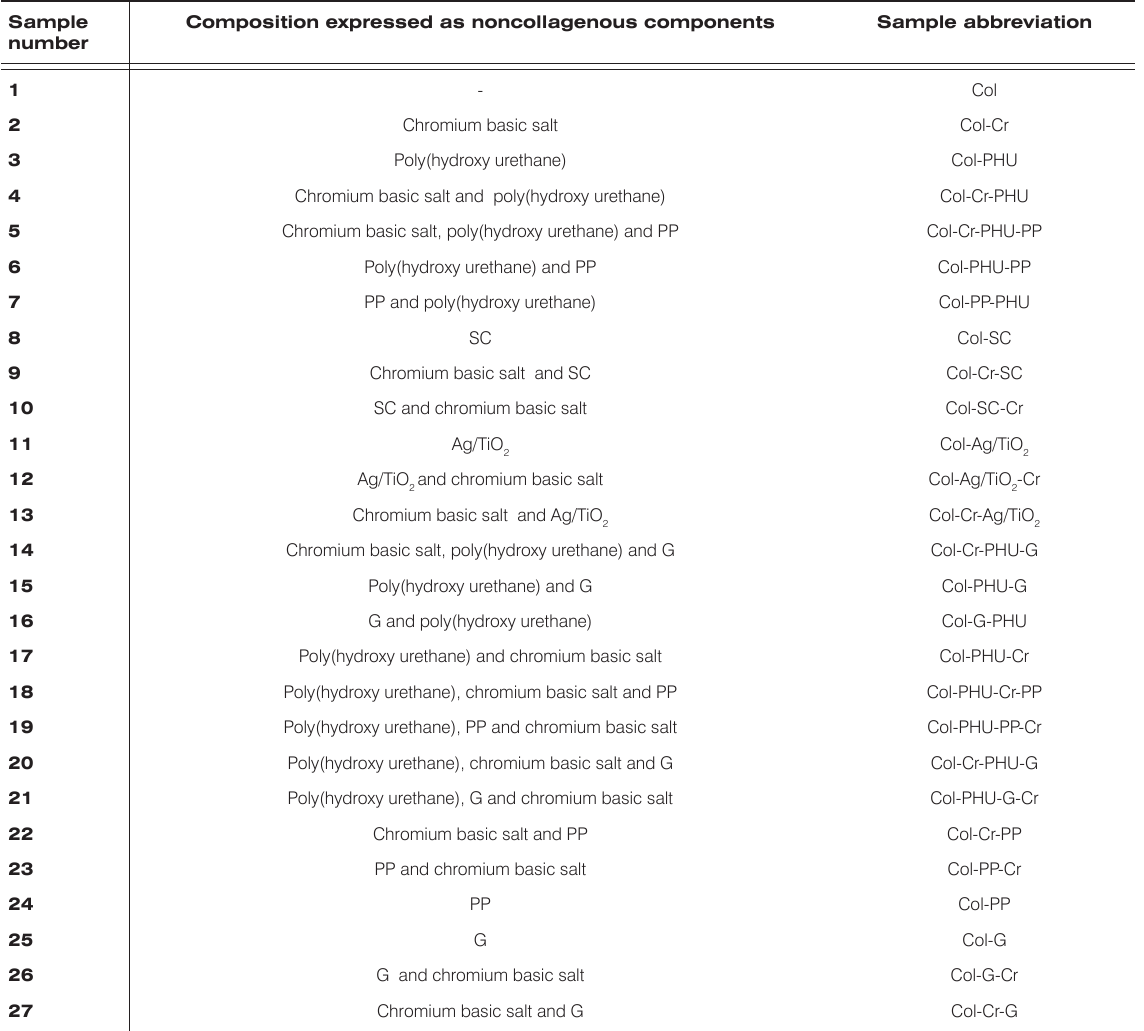
Table 1. Particular compositions of the aqueous collagen-based mixtures investigated through UV-CD.